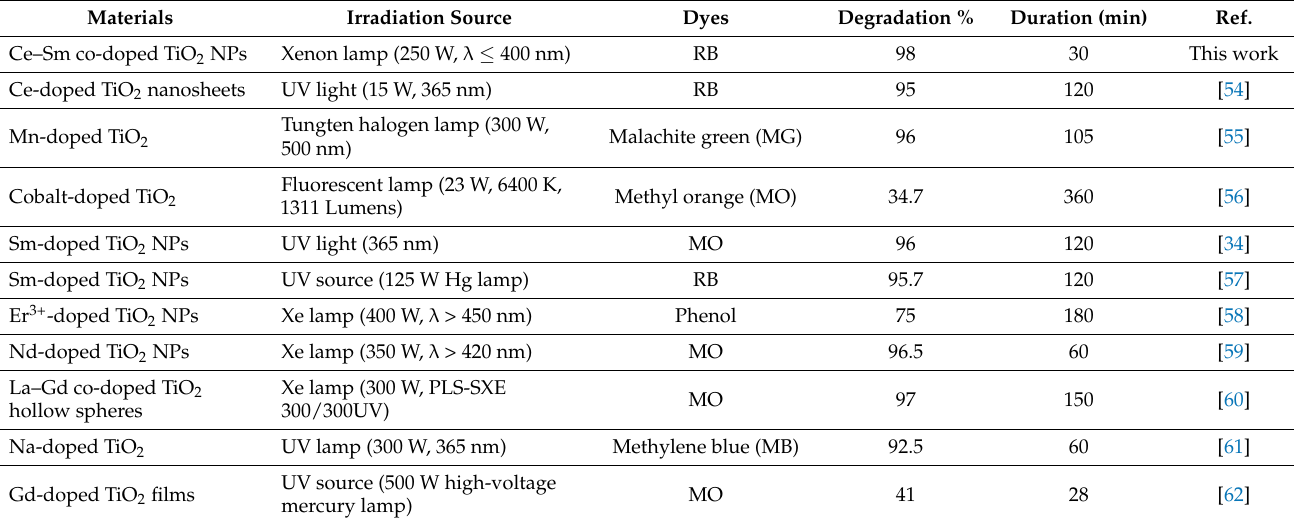
Table 2. List of some TiO 2 -based materials.